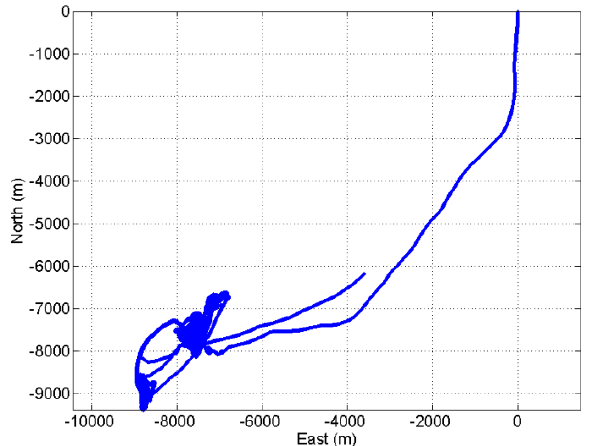
Figure 2. Test trajectory (blue line).